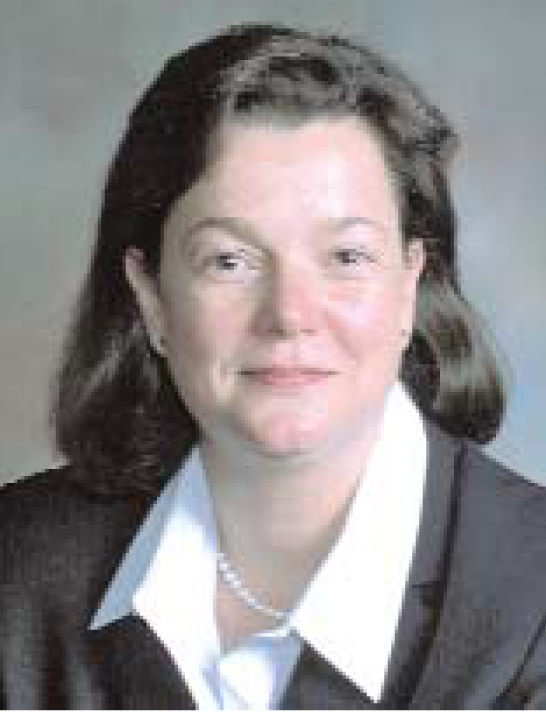
Annette Flanagin